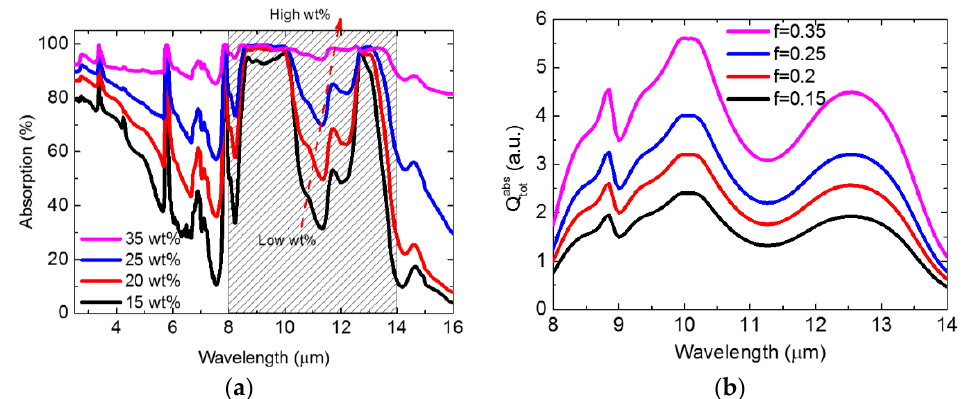
Figure 4. ( a ) Absorption spectra of the SiO 2 –PMMA nanocomposite film. Black, red, blue, and pink lines represent the absorption spectrum of 15 wt%, 20 wt%, 25 wt%, and 35 wt% SiO 2 –PMMA composite films, respectively. ( b ) Resultant powers of collective incoherent SiO 2 particles calculated by Equation (2). Here, the spectrum that we show is consistent with the atmospheric transparency window, and the material dispersion of SiO 2 is based on experimental data. The total powers for 15 wt%, 20 wt%, 25 wt%, and 35 wt% SiO 2 –PMMA composite films are depicted in black, red, blue, and pink lines, respectively. The shadow in Figure 4a indicates the region of transparency window.